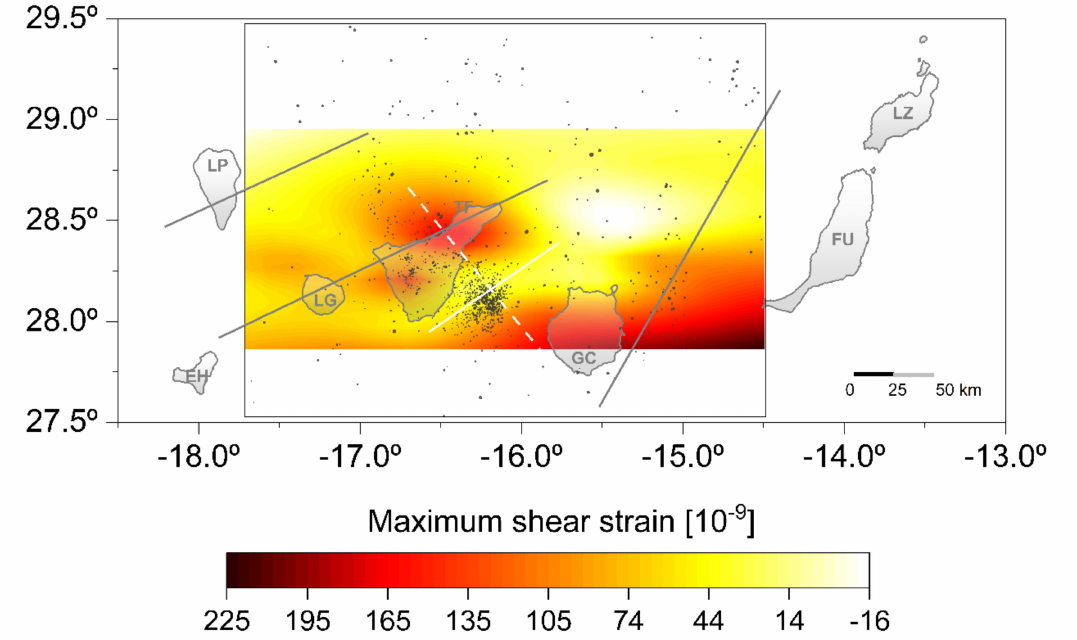
Figure 5. Same contour map as Figure 4b but for maximum shear